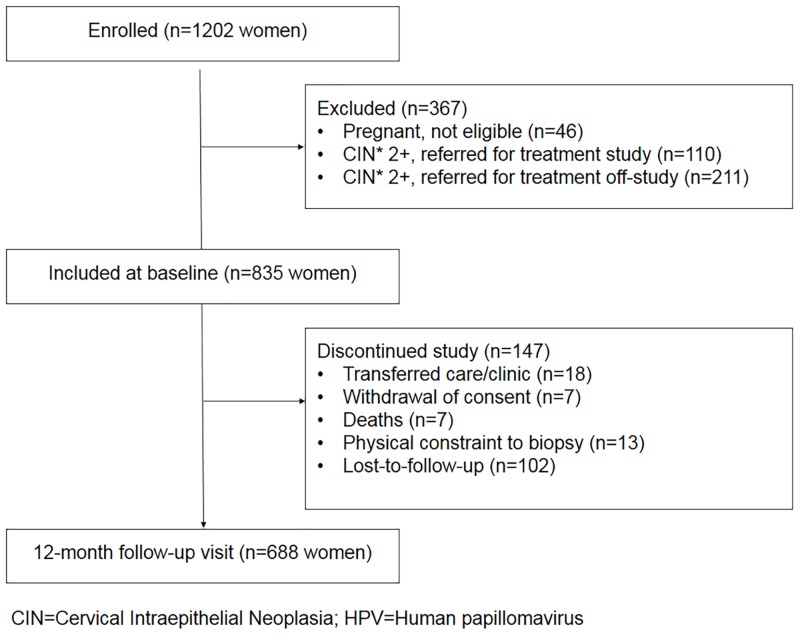
Consort diagram of participant follow-up one year later.CIN = Cervical Intraepithelial Neoplasia HPV = Human papillomavirus.